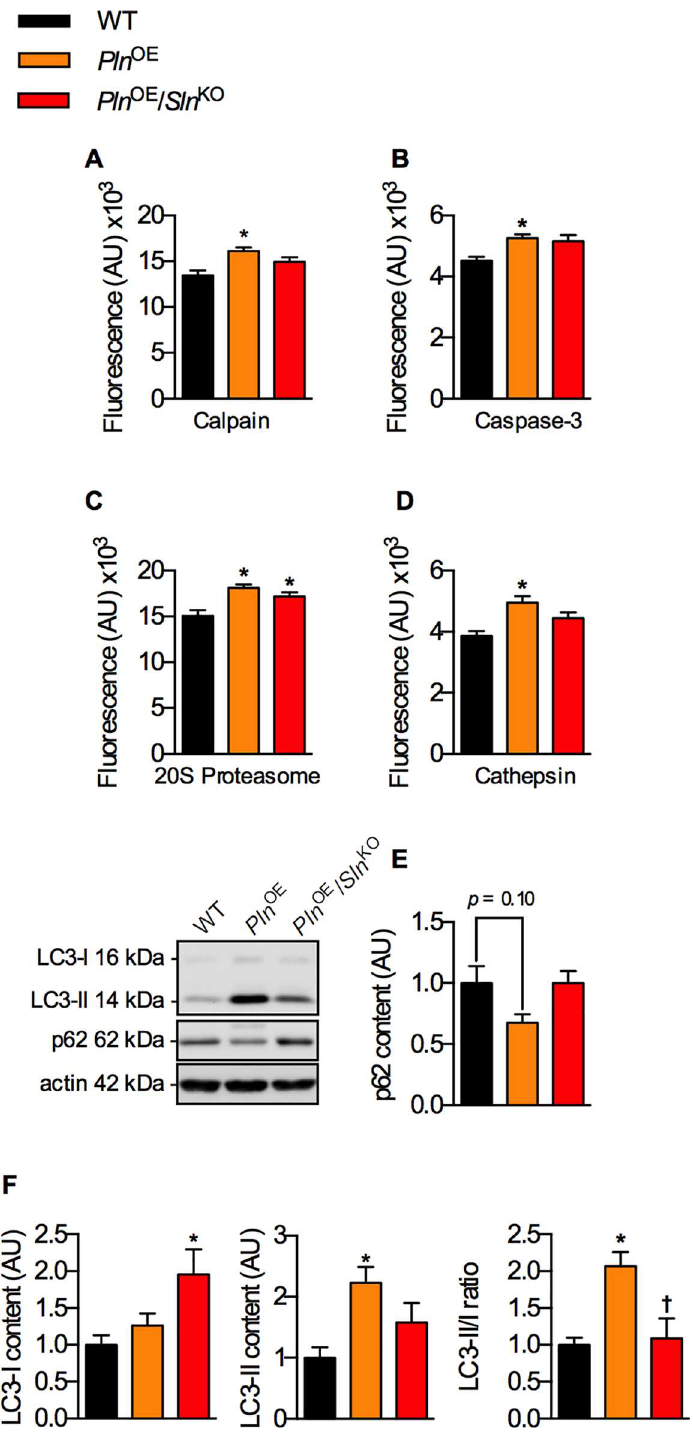
Fig 6. Sln deletion does not augment proteolytic activity and autophagic signaling in response to Pln overexpression. Calpain(A), caspase-3 (B), and 20S proteasome activity assays (C). Enhanced autophagy revealedby increasedcathepsin activity (D), decreased p62 levels(E) and increased LC3-II/I content (F) in Pln OE mice is attenuated in Pln OE / Sln KO mice. * Significantly different from WT, † significantlydifferentfrom Pln OE usinga one-wayANOVA and a Tukey’s post-hoc test, p (cid:20) 0.05. For proteolytic measures, n = 6–7; for p62, LC3-I and–II content, n = 11–12andoptical densitieswerenormalizedto actin. All valuesare means ±